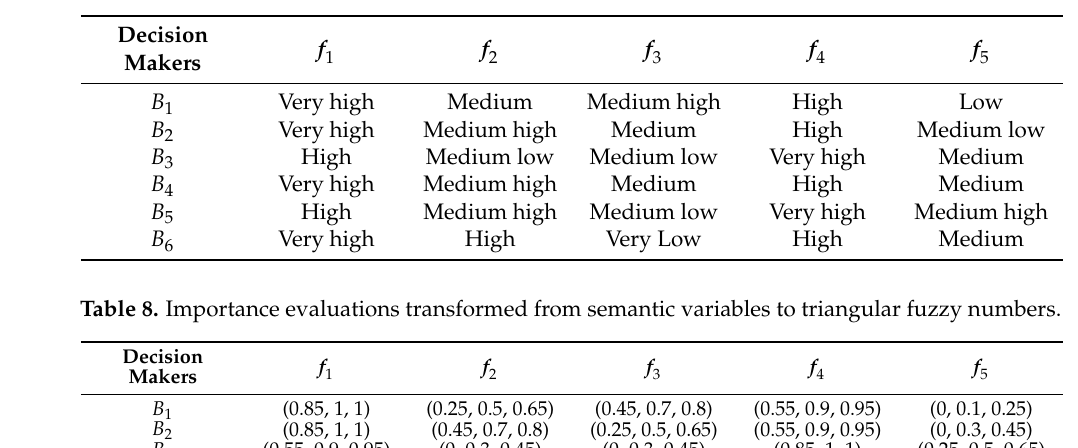
Table 7. Evaluation of the importance of each indicator by engineering decision makers.